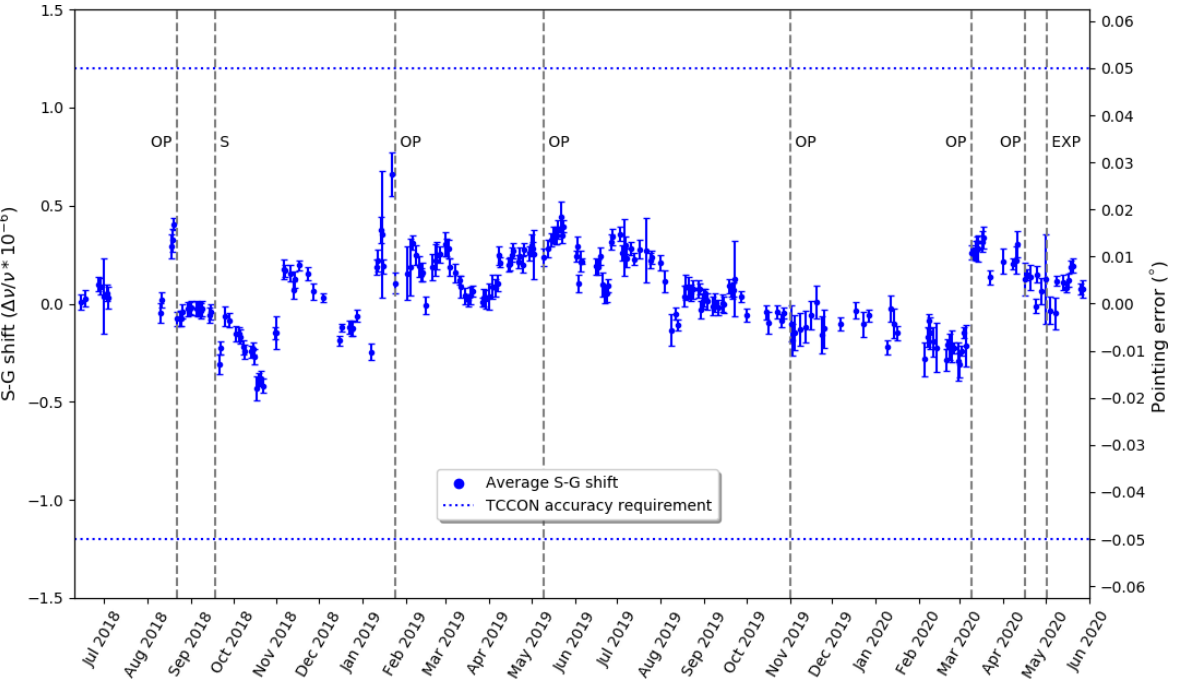
Figure 13. Retrieved S-G shift for measurement days over a 24-month period using Tracker1. Each point is a value for TCCON spectral measurements taken during days that experienced at least 1h of continuous clear sky. Vertical lines mark dates when specific maintenance events were performed on the equipment. Cleaning or adjusting the 45 ◦ mirror optics in front of the spectrometer was performed on events marked as “OP”, and a major alignment was performed on the spectrometer (“S”). Days with high standard deviation are generally the result of cloud-affected measurements, and this is confirmed when looking at the day in detail. On 1 May 2020 (“EXP”), we performed the intentional mispointing experiments, and this day also shows high standard deviation, which was to be